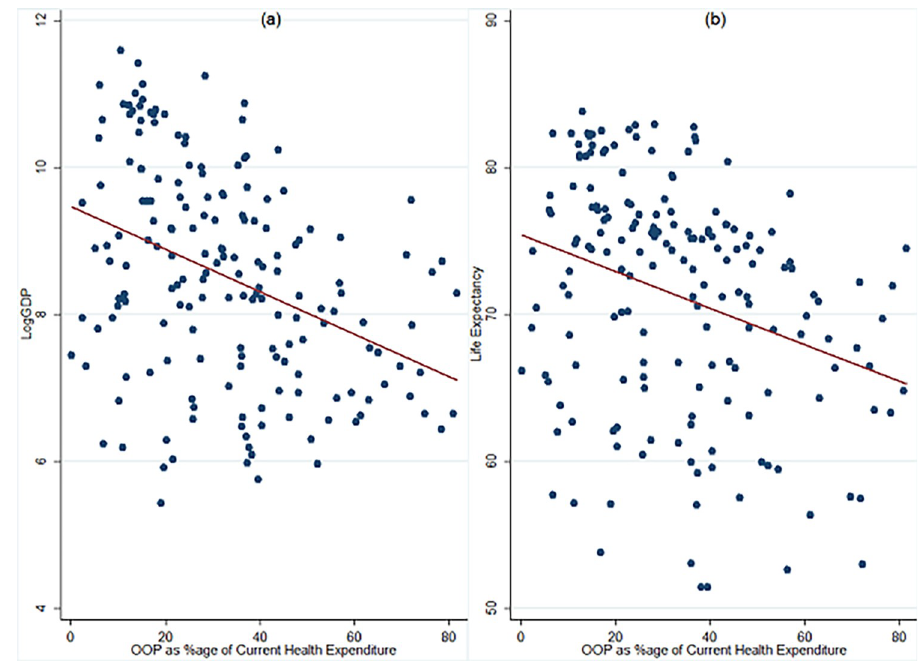
Fig 5. Relationship between income, life expectancy and OOP. a) Scatter plot between LogGDP and OOP b) Scatter plot between LE and OOP. The data pertains to 193 countries and is procured from World Development Indicators (WDI) database of World Bank. LogGDP: Natural Logarithm of real GDP per capita at constant 2010 USD. LE: Life Expectancy at Birth. OOP: Out-of-pocket expenditure as percentage of current health expenditure (CHE). Data of all variables pertains to 2015 and is procured from World Development Indicators (WDI) database of World Bank.